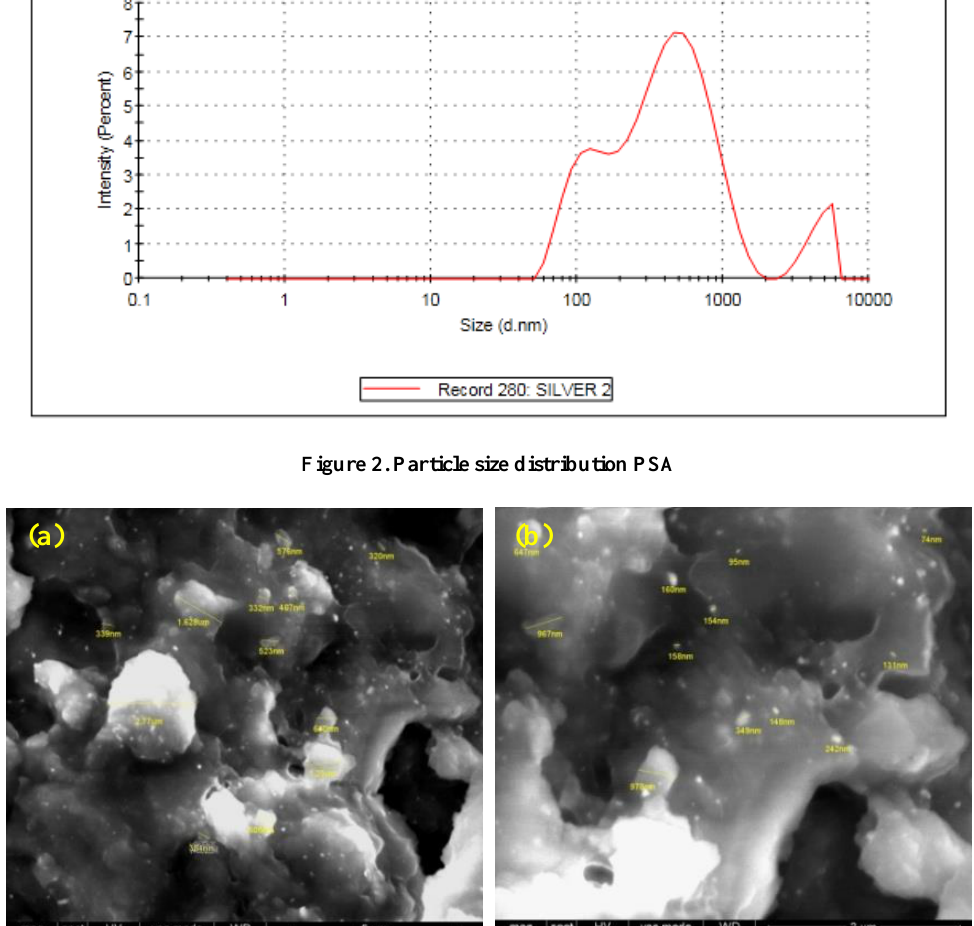
Figure 3. SEM Micrographs of AgNPs (a) 20kX (b)